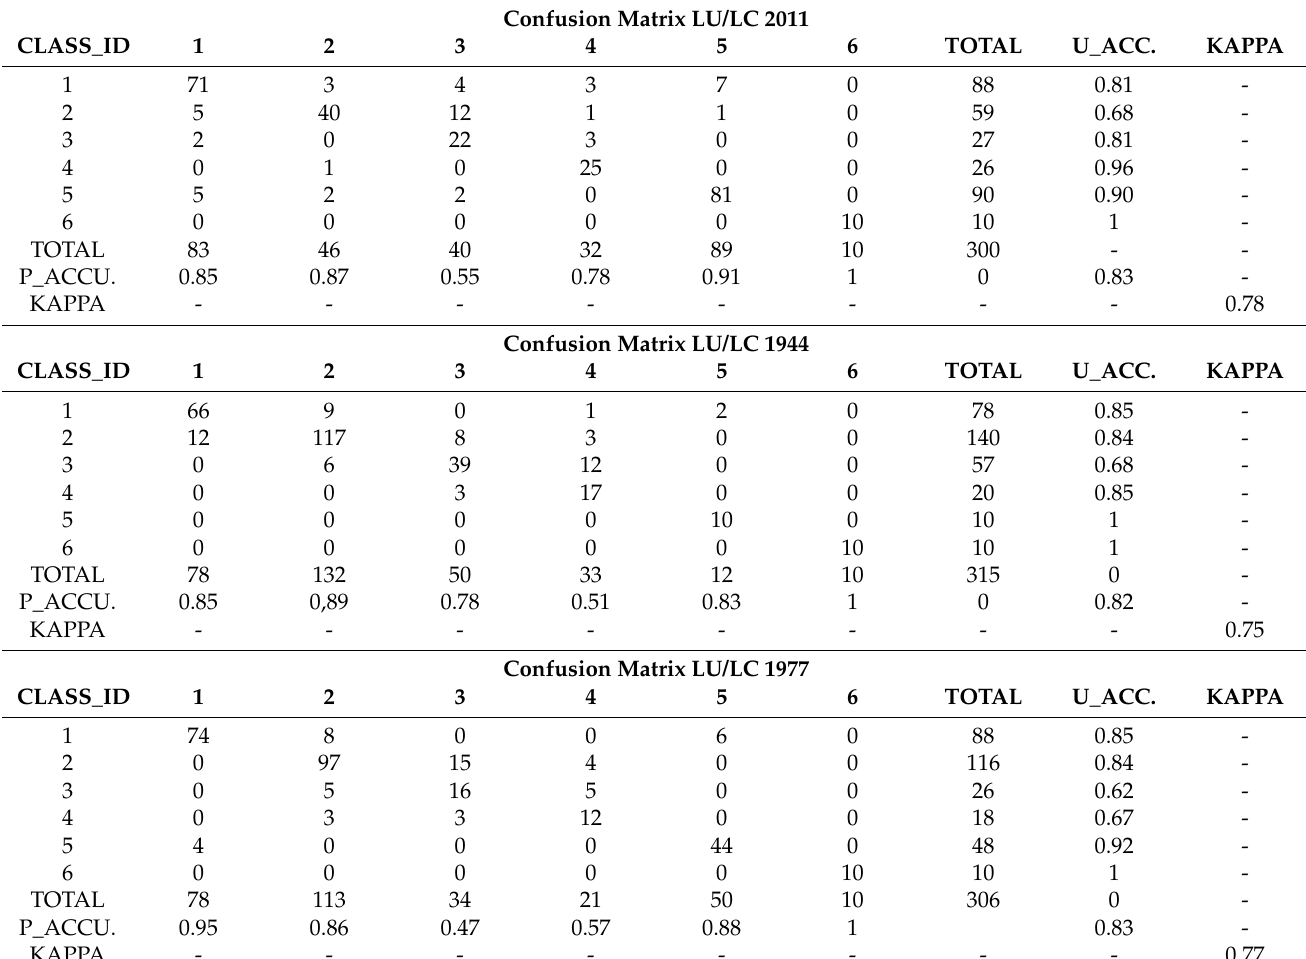
Table 3. Example of confusion matrix table generated for 2011, 1977 and 1944 LU/LC